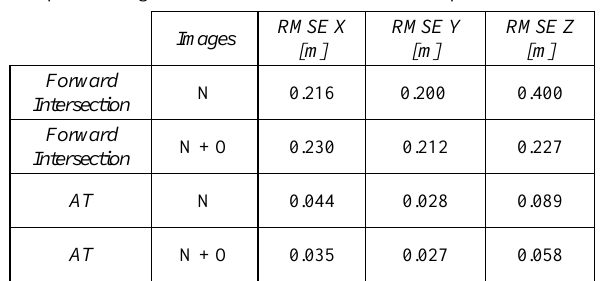
Table 1. Results of forward intersection and AT of Imst nadir (N) and oblique (O) images. The RMSE values refer to 14 independent CPs.